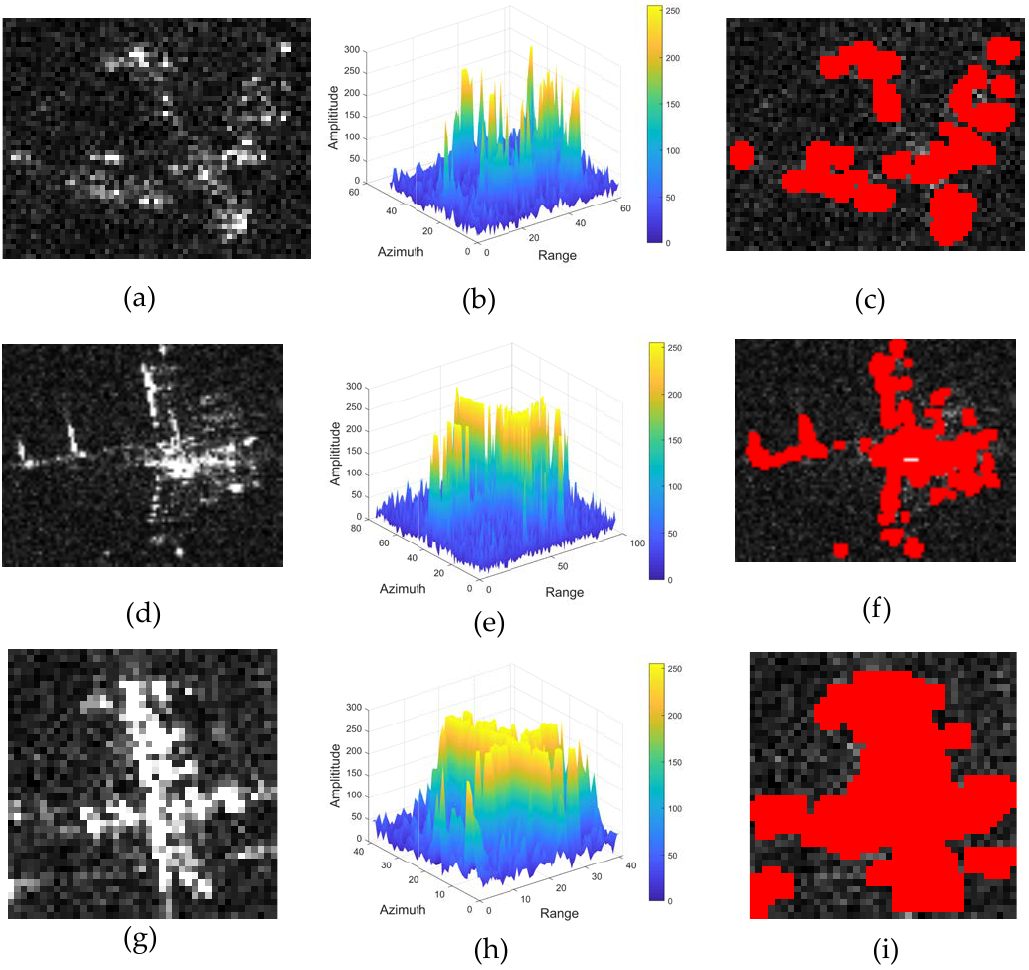
Figure 3. Peak feature extraction of aircraft in SAR images. ( a , d , g ): SAR image of aircraft; ( b , e , h ): 3- dimensional maps of aircraft; ( c , f , i ): Extraction results of peak